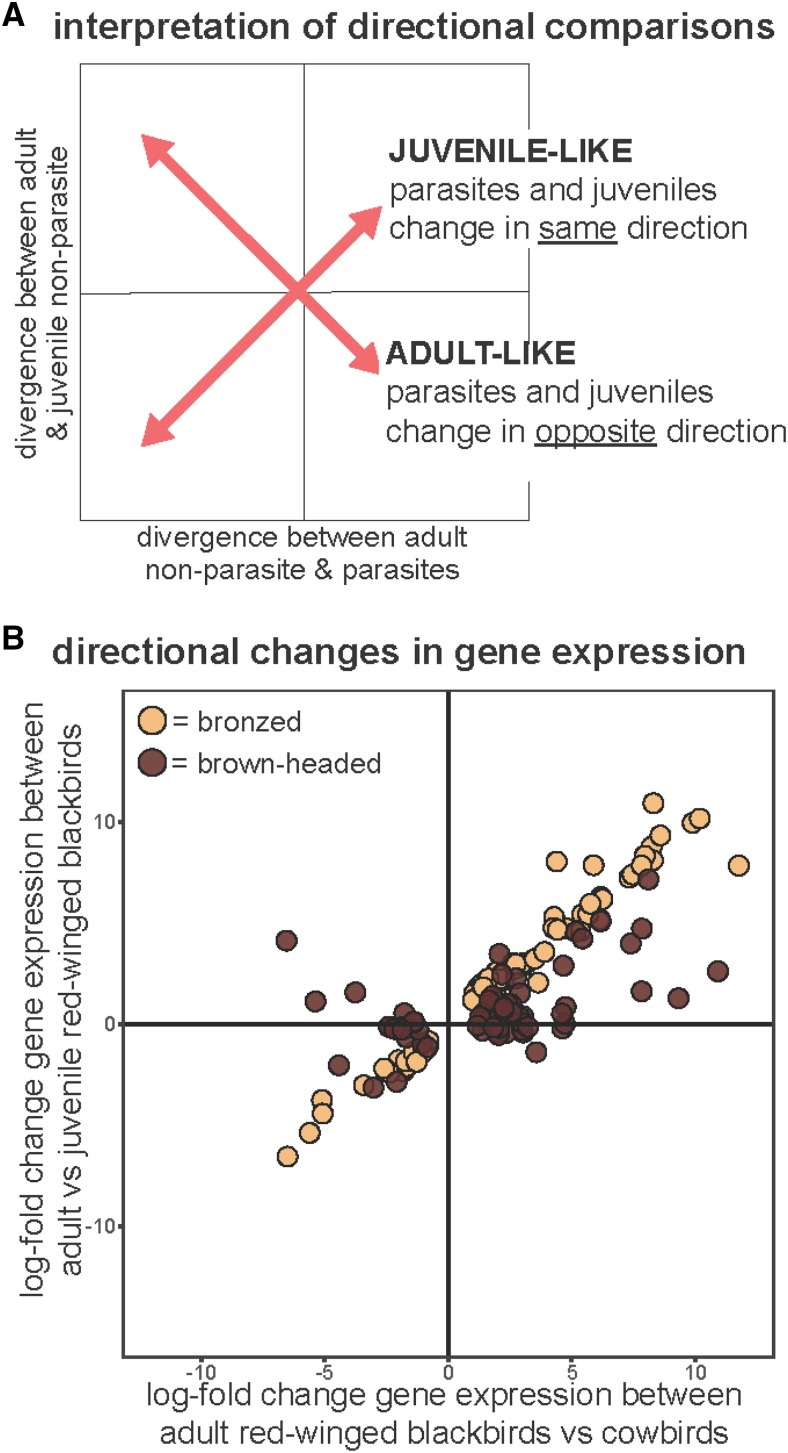
Neotenic patterns of gene expression in the POA of parasitic cowbirds. (A) We interpret gene expression changes in adult parasitic cowbirds as juvenile-like (neotenic) or adult-like compared to non-parasitic blackbirds based on the directional relationship between expression differences. When parasites mirror juveniles the relationship is positive (bottom left and top right quadrant) and when parasites mirror adults the relationship is negative (top left and bottom right quadrant). (B) We find that for both bronzed (tan circles) and brown-headed (brown circles) cowbirds expression patterns are overwhelmingly juvenile-like, with 78% percent of concordantly differentially expressed transcripts exhibiting juvenile-like expression (χ2 = 7.25, P = 0.0071).